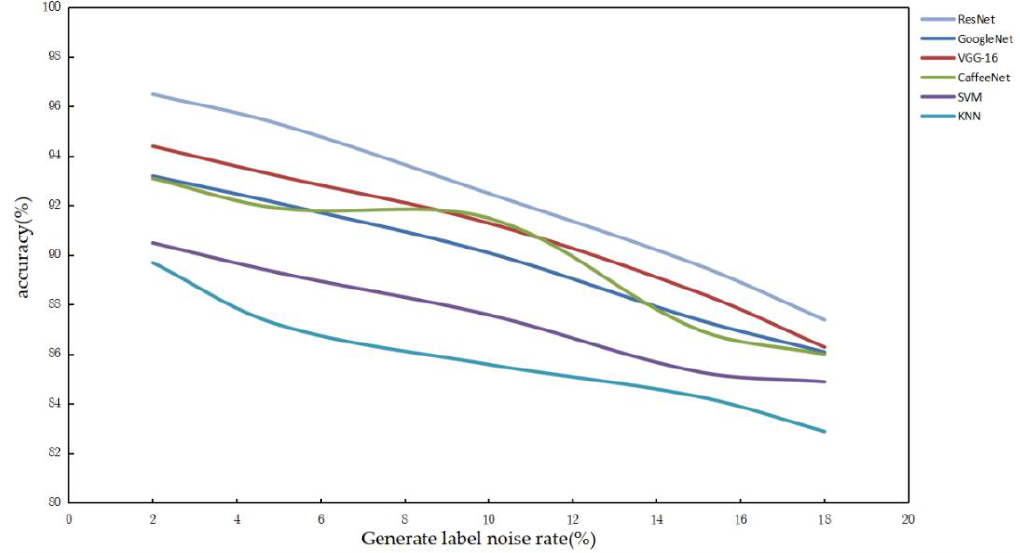
Figure 12. Comparison of the noise immunity performance of various image classification algo- rithms.